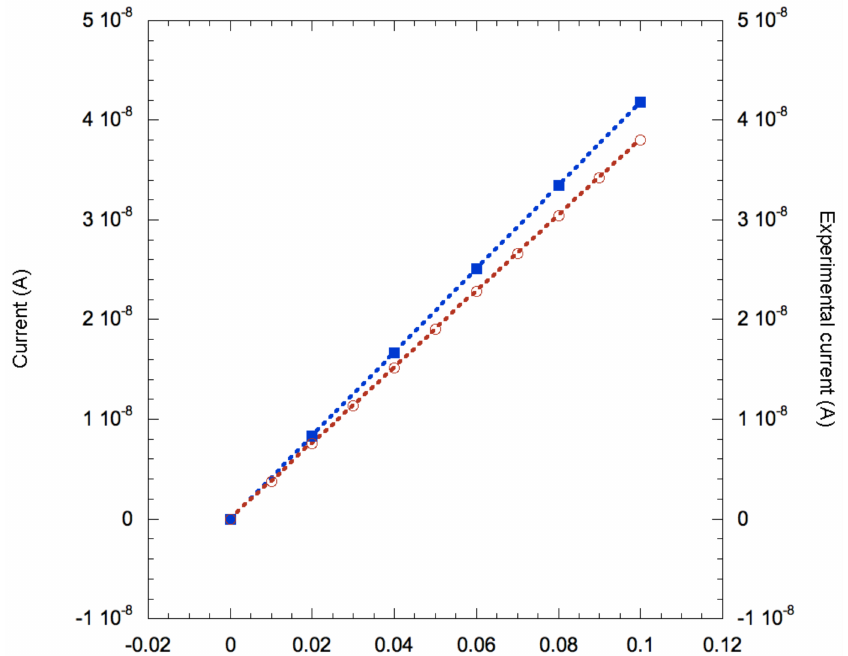
Figure 3. Comparison between I–V characteristics from Tibercad simulation (blue symbols) and experimental data (red symbols). Lines are guide for the